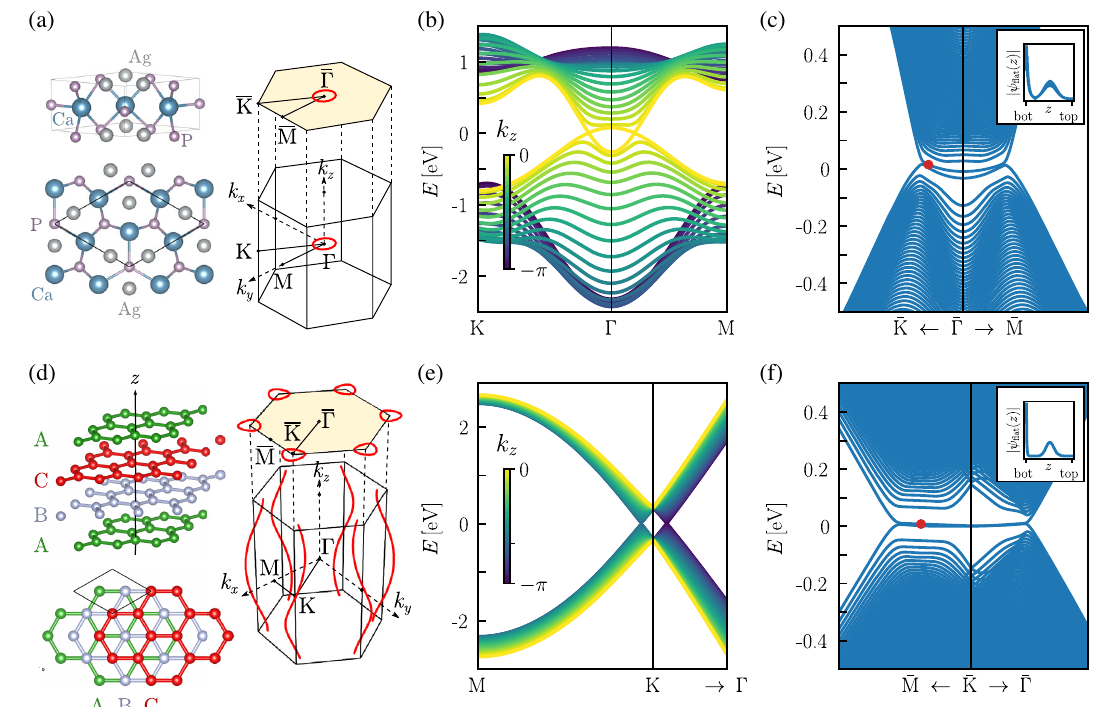
FIG. 3. Three-dimensional flat bands in nodal-line semimetals CaAgP (first row) and rhombohedral graphite (second row). (a) Top and side views of the CaAgP crystal structure. Next to these, we indicate the shape and position of its nodal circle (red), which is centered at the Γ point of the hexagonal Brillouin zone. The beige hexagon represents the (001) surface Brillouin zone with the surface projection of the nodal loop. (b) Bulk bands of the two-band tight-binding model without strain along paths with fixed k z . The bands only cross in the plane k z ¼ 0 . (c) Tight-binding spectrum of a strained (001) slab for L ¼ 200 , R ¼ 800 with nearly flat bands. The inset shows the spatial profile of the flat-band wave function at the momentum indicated by the red dot. It is a superposition of a bottom-surface state and a (Gaussian) Landau-level state. (d) Top and side views of ABC-stacked (rhombohedral) graphite next to a sketch of its nodal lines. In contrast to CaAgP, there are several nodal lines that spiral around axes going through the K and K ’ points of the hexagonal Brillouin zone. Their projections into the surface Brillouin zone form approximate nodal circles. (e) Bulk bands of the two-band tight-binding model without strain along paths with fixed k z . The nodal spiral crosses the considered path for two different values of k z . (f) Tight- binding spectrum of a strained (001) slab for L ¼ 100 , R ¼ 400 with flat bands. The inset shows the spatial profile of the flat-band state at the red dot, which is again composed of a Landau-level and a bottom-surface